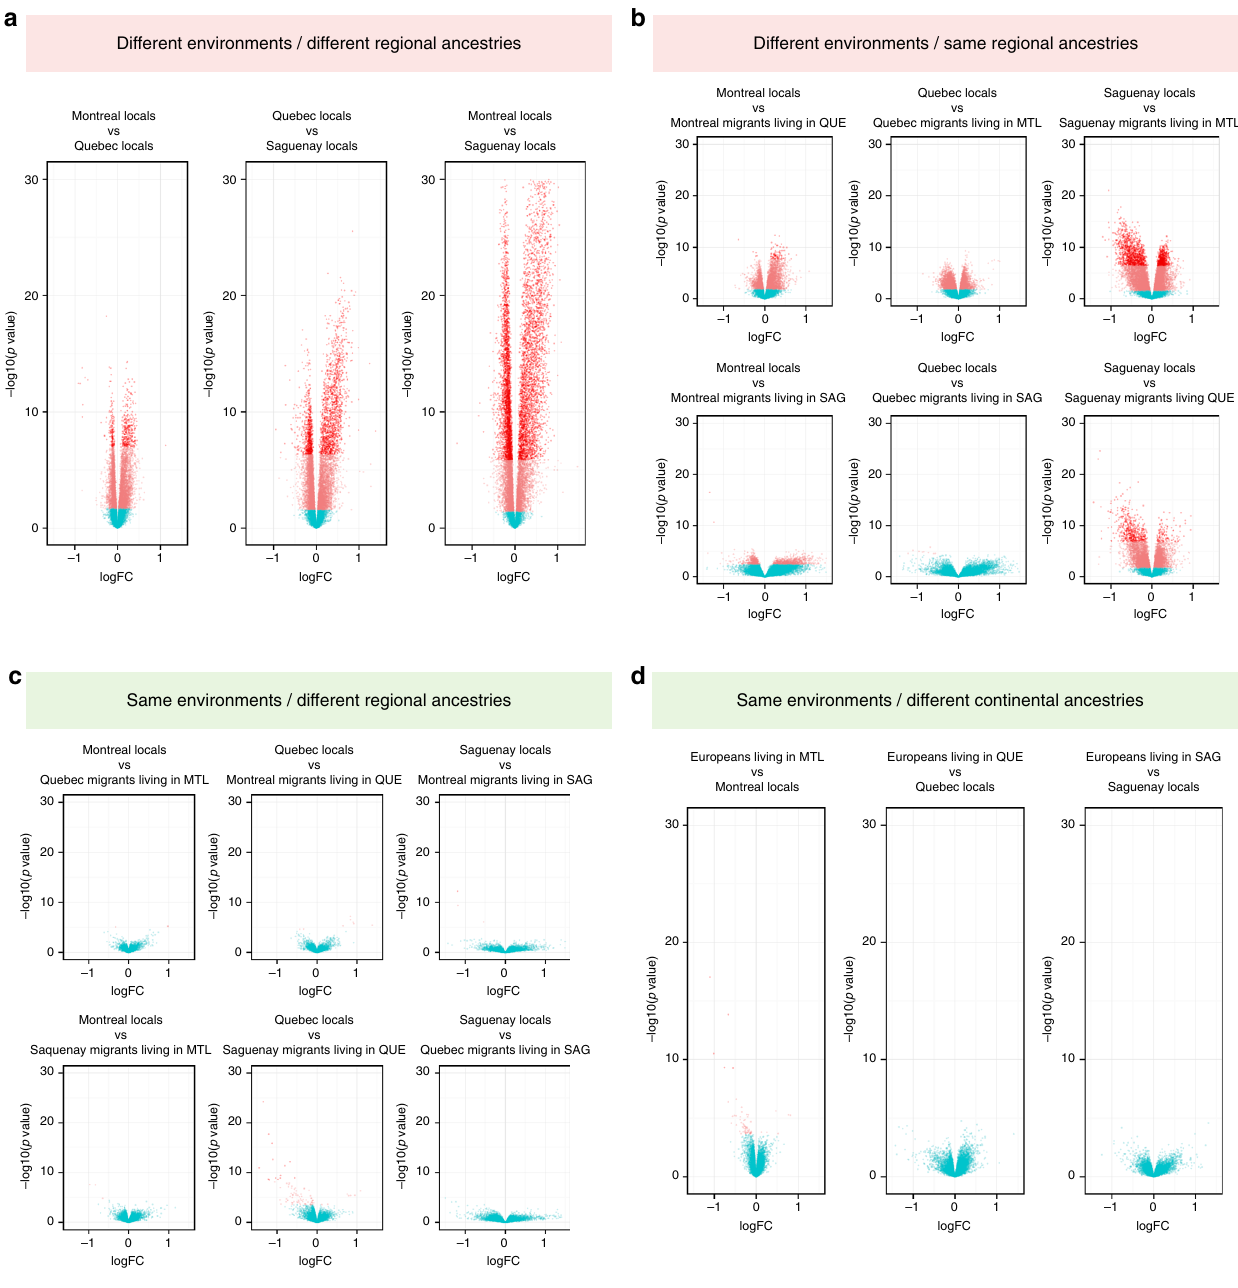
Fig. 2 Environmental impacts on gene expression pro fi les override that of genotype. Contrasting the effects of ancestry and regional environment on differential gene expression. a Between FC-locals (different regional ancestry, different regional environments). b Between FC-locals and FC regional migrants (same regional ancestry, different regional environments). c Between FC-locals and FC regional migrants (different regional ancestries, same regional environment). d Between FC-locals and Europeans (different continental ancestries, same regional environment). Pink dots are genes with FDR ( q value) below 5% and red dots are genes with p value < Bonferroni-corrected p value (3.20 × 10 − 6 aspartate aminotransferase level (AST), and gamma-glutamyl (Supplementary Fig. 12), and expression levels of differentially transferase (GGT)) show the strongest associations with annual expressed genes and their regulators (Supplementary Fig. 10). All SO 2 and O 3 ambient levels (Supplementary Fig. 10). In our phenotypes are standardized health tests captured by CARTa- cohort, the gradient of SO 2 exposure is associated with detectable GENE, and all self-reported disease diagnostics were cross- detrimental effects on cardio-respiratory phenotypes, more so validated with electronic health records of the participants 19 . Consistent with previously documented effects of air pollution on than ambient annual PM2.5 and NO 2 levels (Supplementary cardiac and respiratory traits 32,33 , we fi nd that arterial stiffness Fig. 10), and is the environmental variable that has the highest measures, asthma and stroke prevalence, monocytes counts, low- replicability of association with gene expression (Fig. 3). As a density lipoprotein (LDL), respiratory function (FEV1), as well as result of these strong associations of annual SO 2 ambient levels liver enzyme levels (Alanine aminotransferase level (ALT), with detrimental cardio-respiratory phenotypes, and as O 3 levels